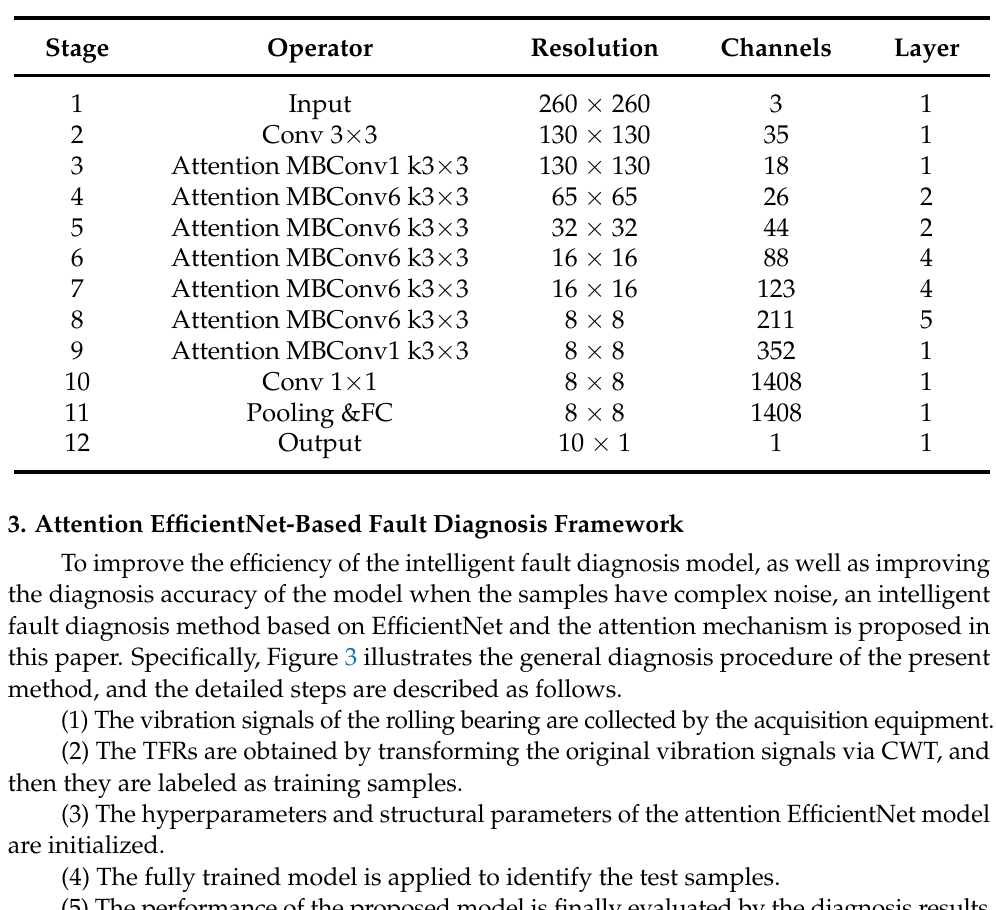
Figure 2. An overview of attention EfficientNet. Table 1. Overall structure of attention